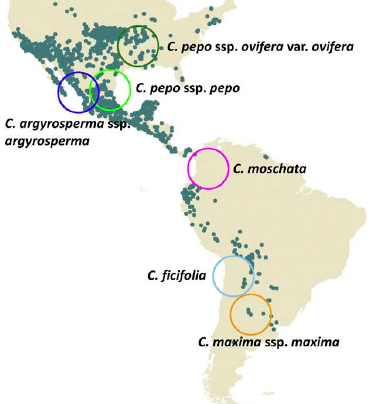
Figure 2. Distribution map of wild species of Cucurbita with occurrences based on 7000 records from GBIF (www.gbif.org, accessed on 15 November 2020). Hypothesized origins of domestication for the five Cucurbita species are indicated by open circles. C pepo was split into the two cultivated spp. C. pepo ssp. ovifera : dark green; C. pepo ssp. pepo : light green; C. argyrosperma ssp. argyrosperma : blue; C. moschata : magenta; C. ficifolia : light blue; C. maxima ssp. maxima : orange [30]. Copyright 2021 Kates, Lopez-Anido, Sánchez-de la Vega, Eguiarte, Soltis and